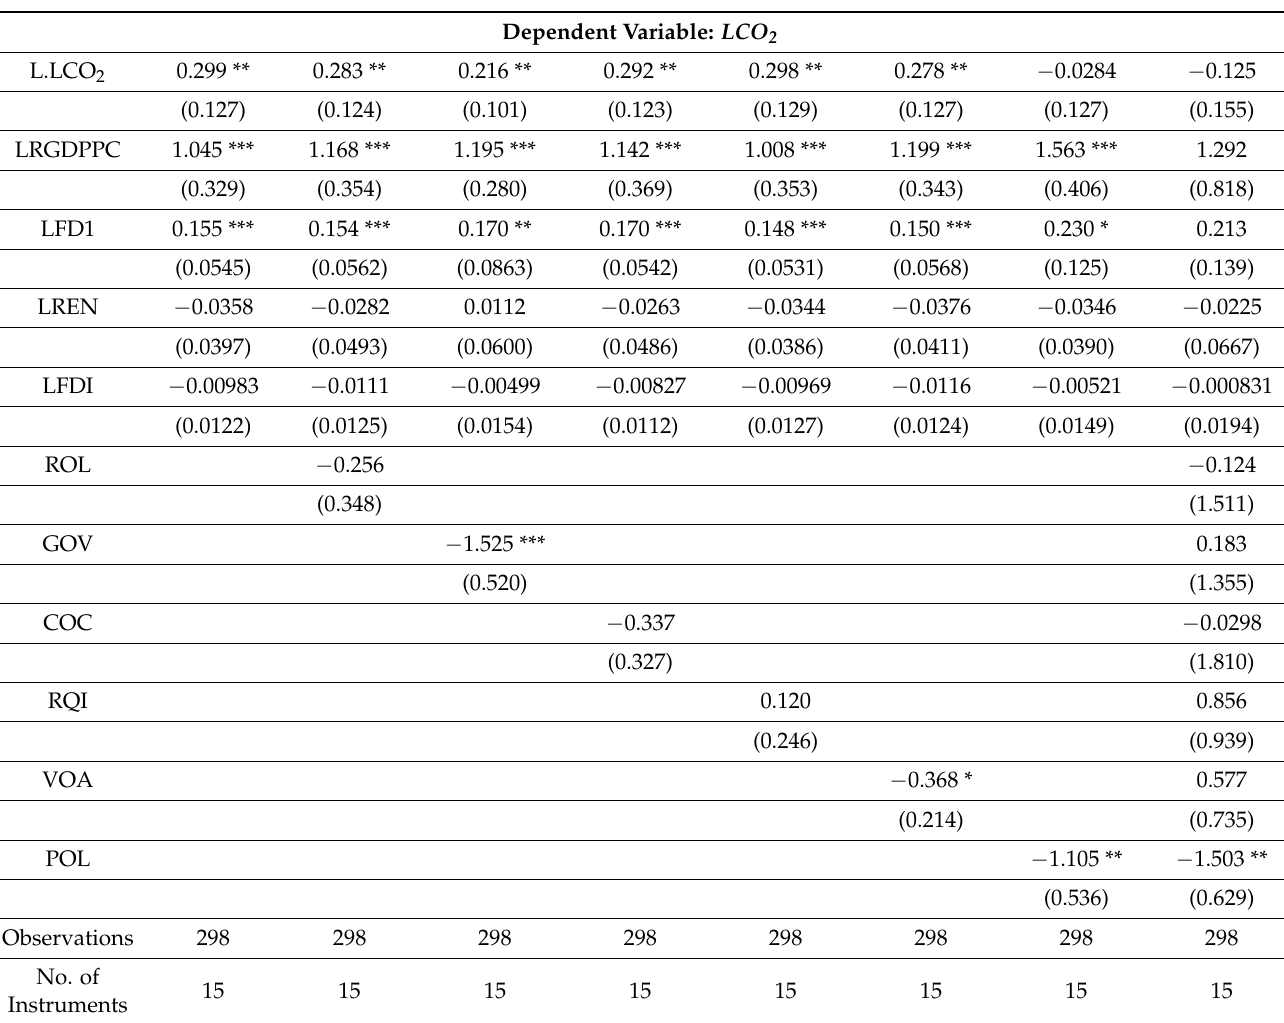
Table 4. Results of dynamic panel-data estimation, two-step system GMM-financial development, proxied by (i) domestic credit to the private sector (% of GDP)